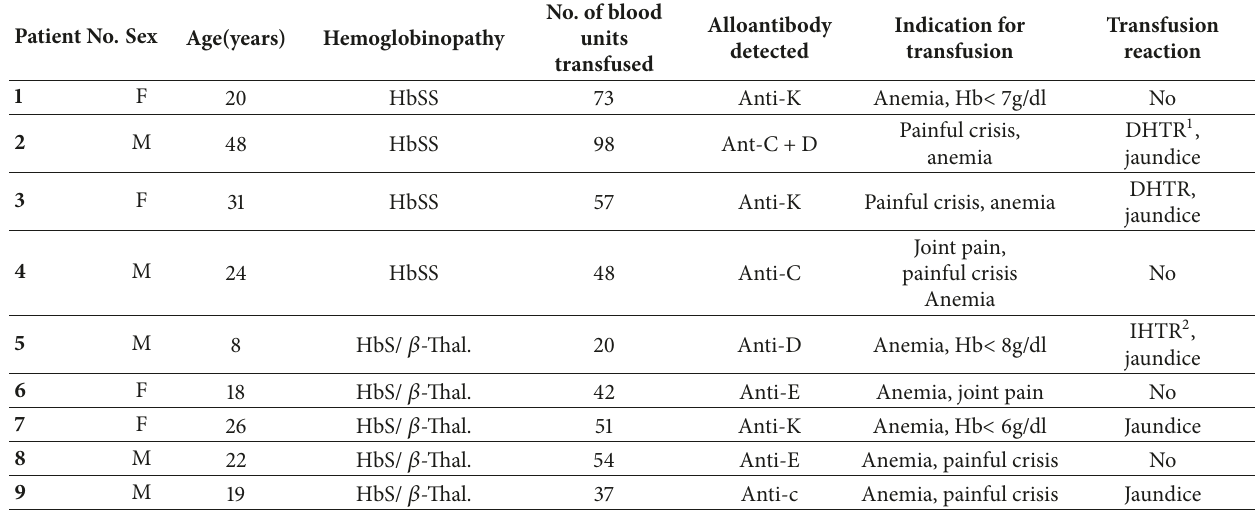
Table 3: Characteristics of alloimmunized SCD patients (HbSS and HbS/ 𝛽 -thal). Patient No.